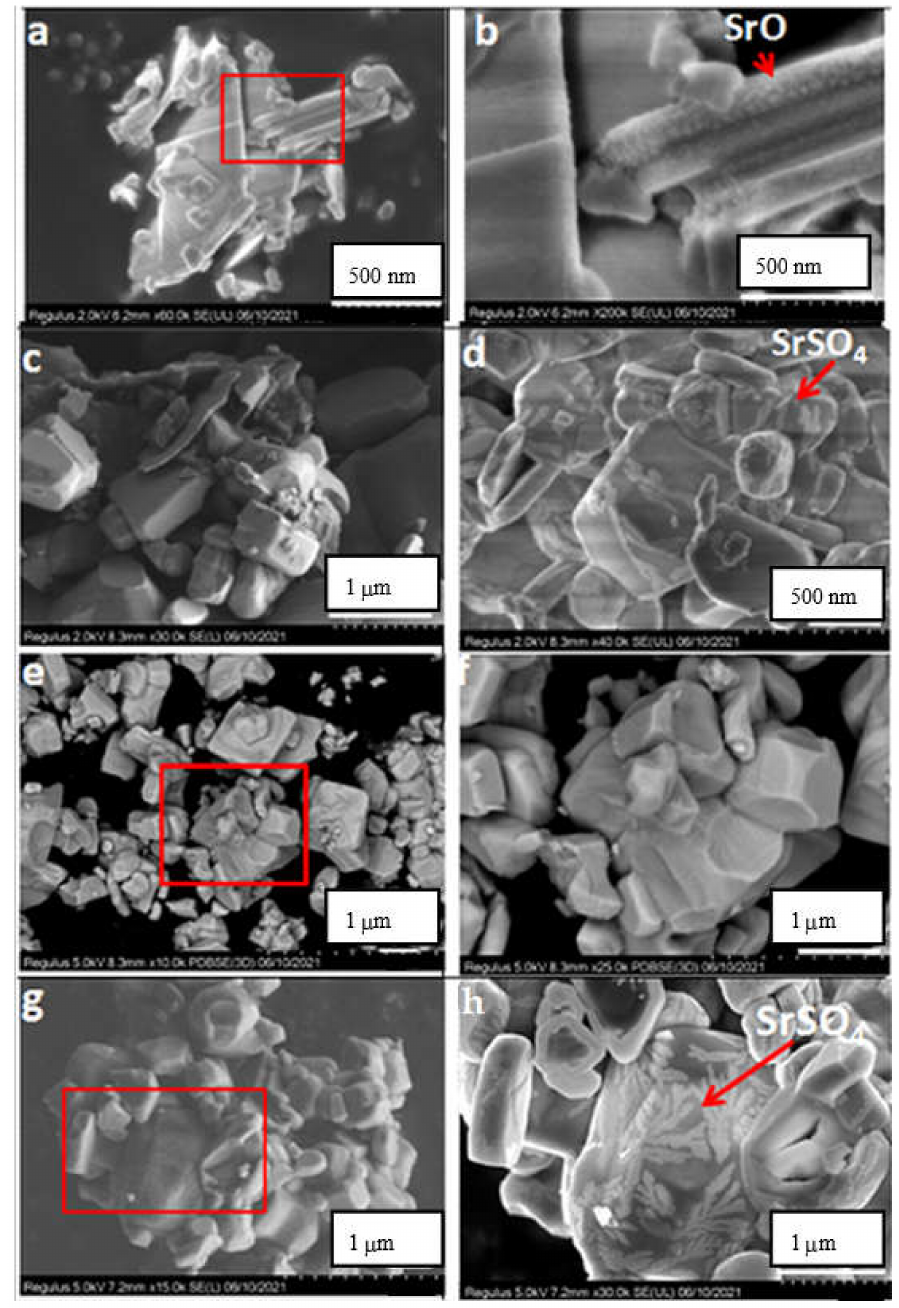
Figure 12. FE-SEM images at different magnifications for the samples calcined at 1100 ◦ C: MA-1 ( a , b ), MA-2 ( c , d ), MA-3 ( e , f ), MA-4 ( g , h